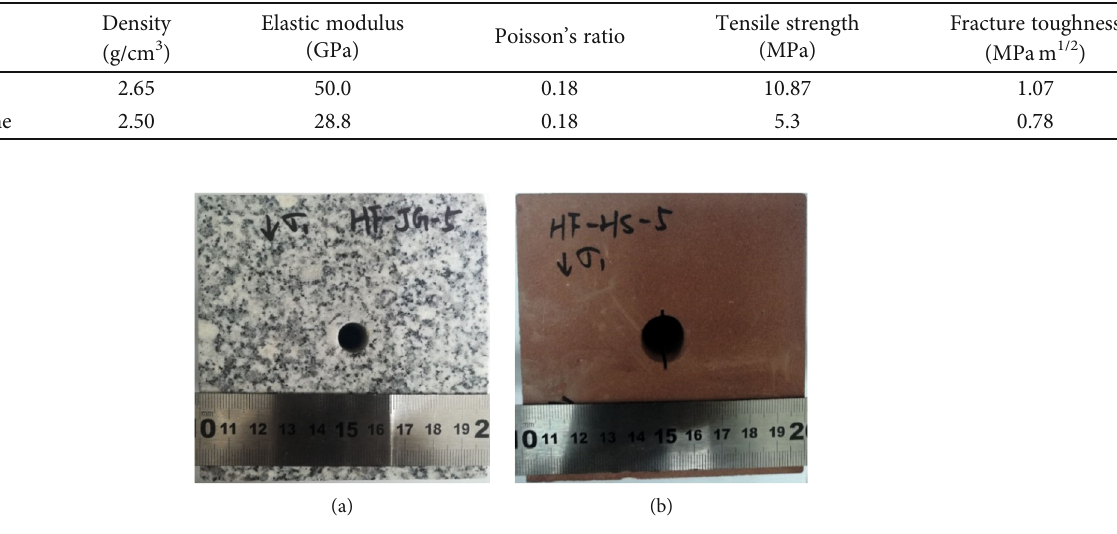
Table 1: Physical and mechanical properties of the rock samples.